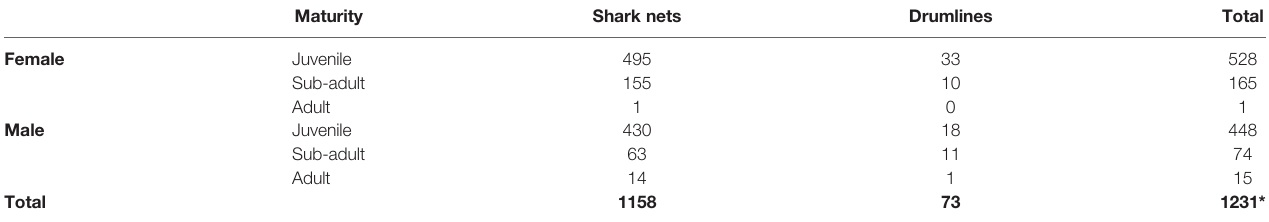
TABLE 3 | Catches of white sharks ( Carcharodon carcharias ) in the KwaZulu-Natal beach safety program from 1978 – 2018 (shark nets) and 2007 – 2018 (drumlines).